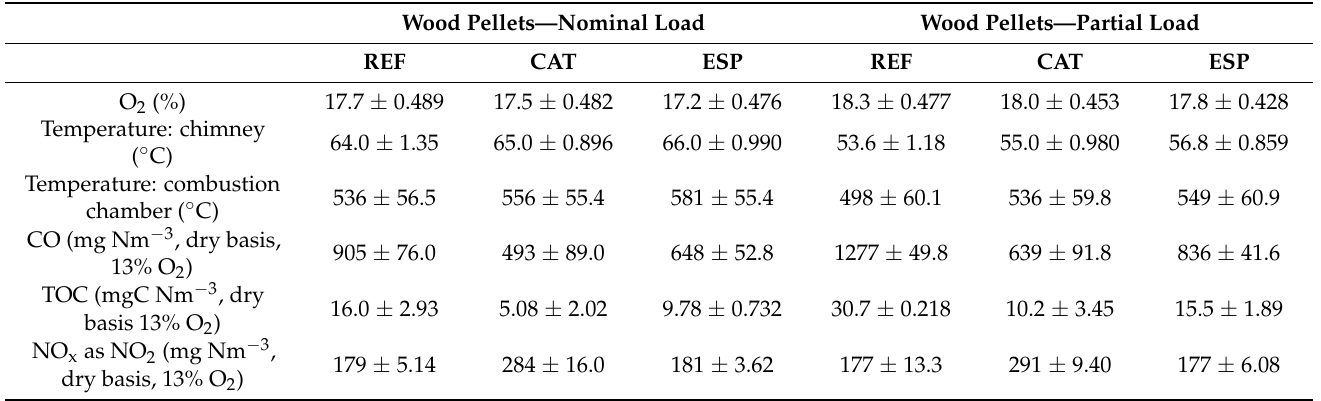
Table 3. Operating parameters of wood pellet combustion and CO, TOC, and NO x emission concen- tration at 13% of oxygen.